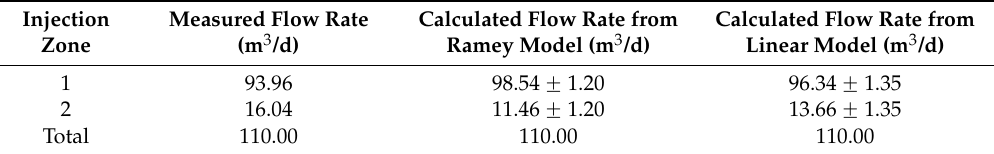
Table 2. Measured and calculated flow rates in m 3